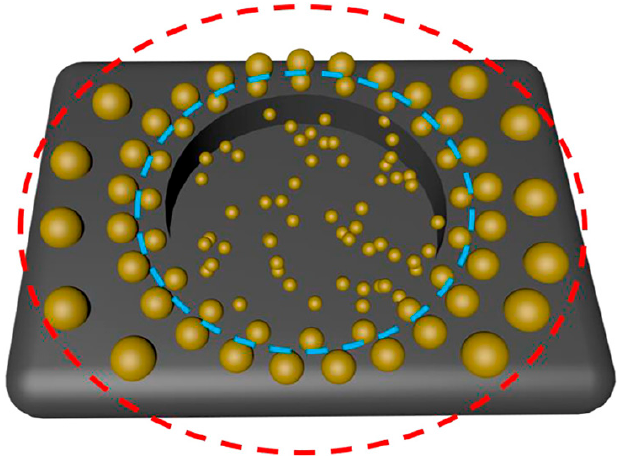
Figure 3. Diagram of active phase sintering occurring over a support material: the blue ring represents atomic migration to form larger crystallites; the red ring represents the coalescence of crystallites. Adapted with permission from ref. [50]. Copyright 2021 Elsevier.